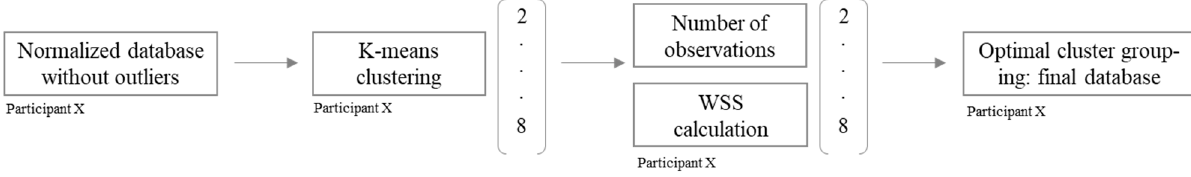
Figure 2. Cluster calculation procedure of the final database for each subject, from the normalized database to the final cluster grouping.